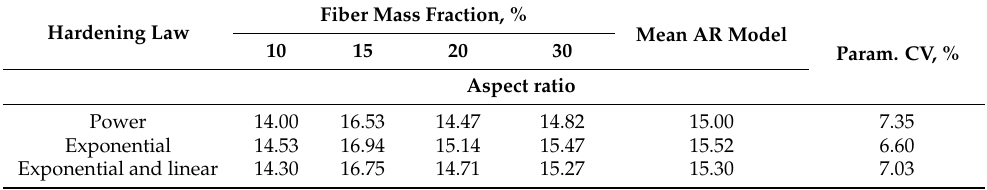
Table 3. Fiber aspect ratio (AR) calibration for composites with different fiber mass fraction. Hardening